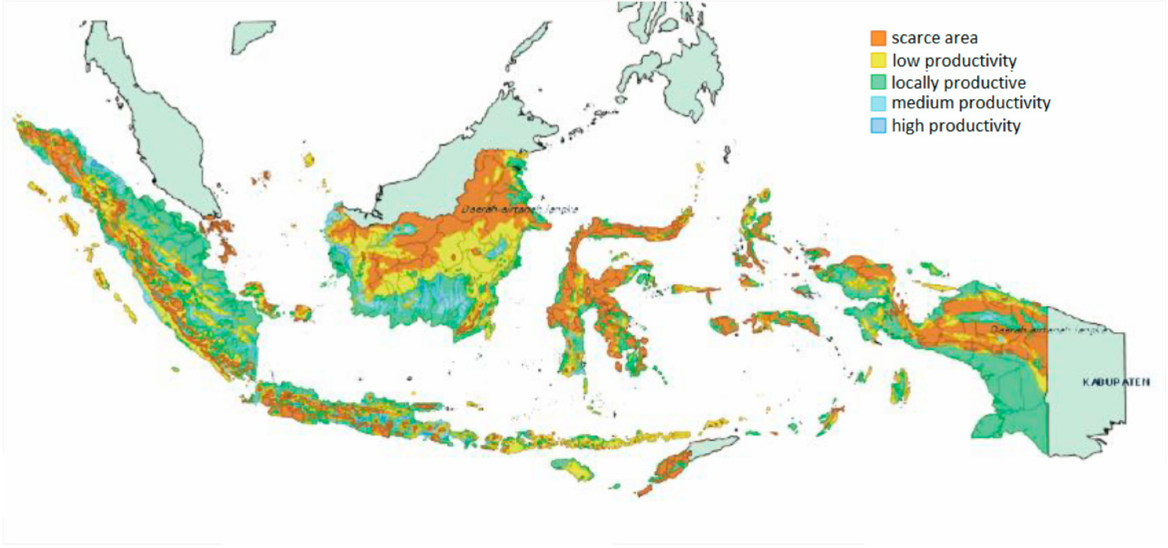
Figure 5. Map of groundwater aquifer productivity in Indonesia. Image from [37] with edited